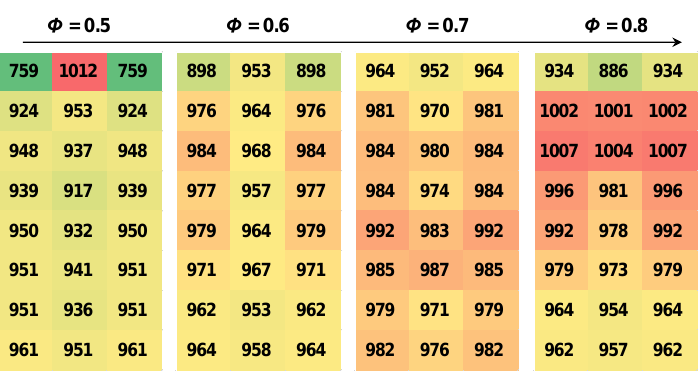
Figure 10. Temperature distributions for various overall equivalence ratios at p = 150 kPa and S = 4.56. The O 2 concentration does not vary much with the overall equivalence ratio as shown in Figure 11.